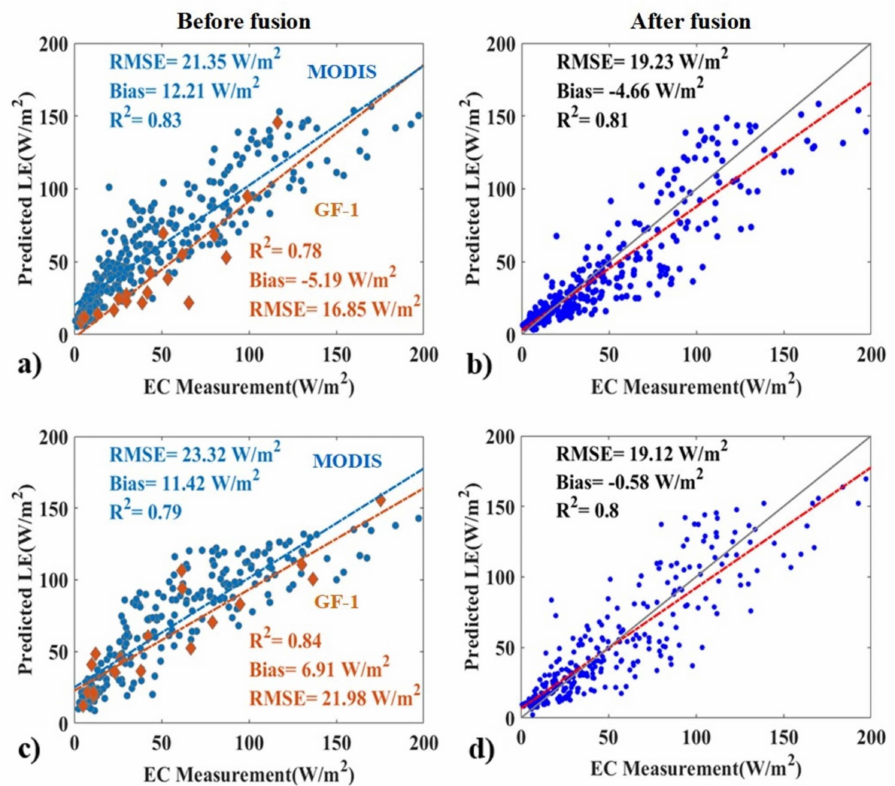
Figure 11. Scatter plots of MODIS LE, GF-1 LE, and integrated LE products validated by the EC measurements: ( a , b ) for EC 10 m site; ( c , d ) for EC 40 m site. The red line is the fitting line and the black line is the 1:1